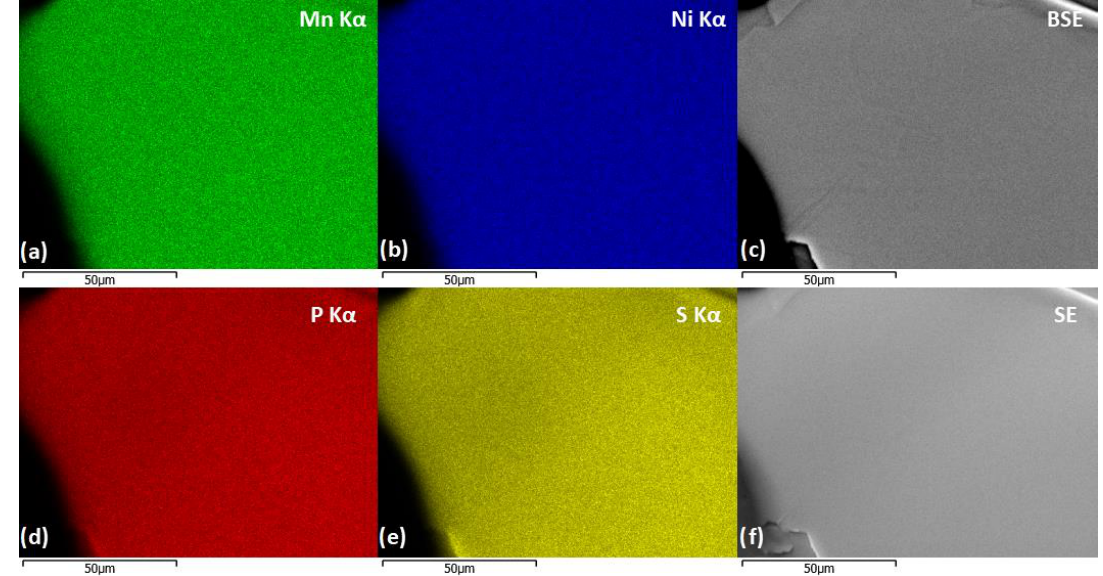
Figure 2. ( a , b , d , e ) Elemental mapping, ( c ) backscattered electron (BSE) image, and ( f ) secondary electron (SE) image from a (Mn 0.7 Ni 0.3 ) 2 P 2 S 6 crystal.